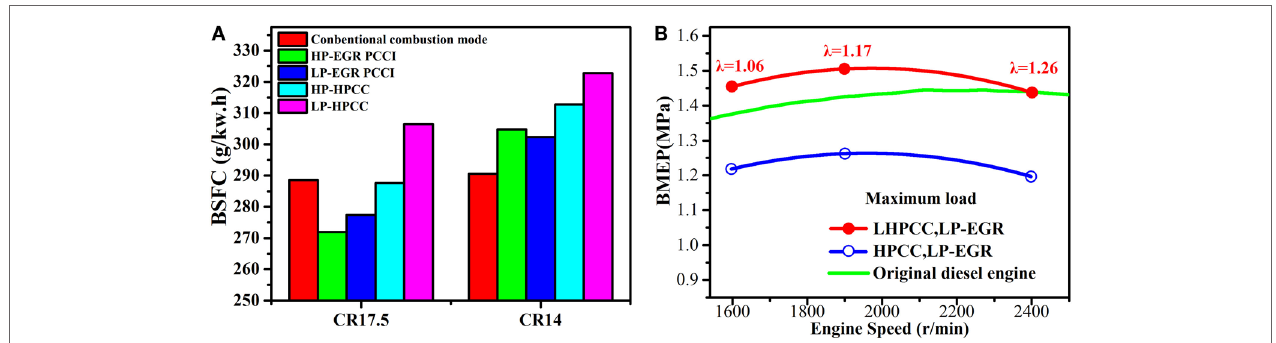
FiGURe 12 | Comparison of (A) BSFC between PCCi and HPCC under low load conditions (0.25 MPa BMeP) and (B) the maximum load between original diesel engine, L-HPCC and HPCC with low pressure eGR